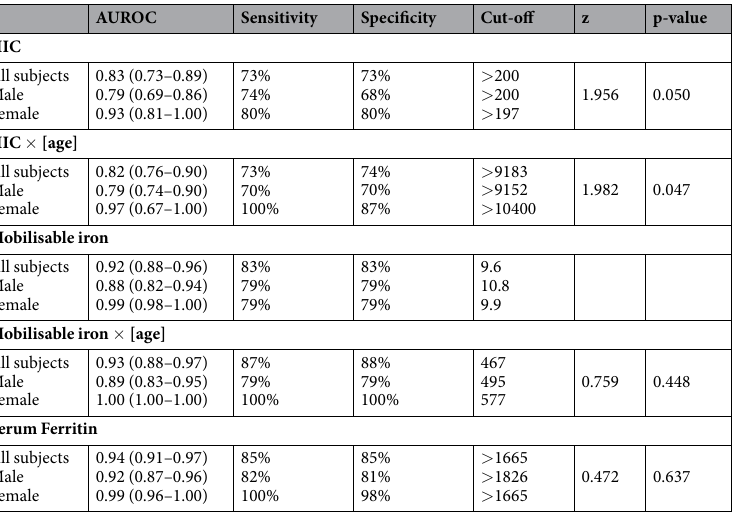
Table 3. ROC analysis reporting AUROC, sensitivity, specificity for HIC ( µ mol/g); HIC × [age] ( µ mol/g.yr); Mobilisable iron (g); Mobilisable iron × [age] (g.yr); serum ferritin ( µ g/L) in the detection of advanced hepatic fibrosis in HH subjects. 95% confidence intervals are show in brackets. The AUROC for mobilisable iron was compared with each of the other parameters using the method of Hanley and McNeil, generating a z-score and p-value 17 . AUROC, area under the receiver operator characteristic; HIC, hepatic iron